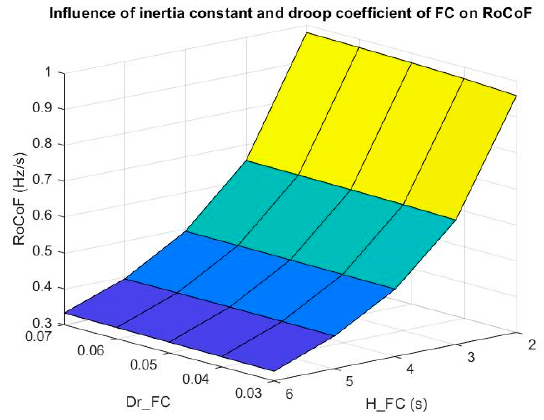
Figure 7. Influence of H and D r on RoCoF.